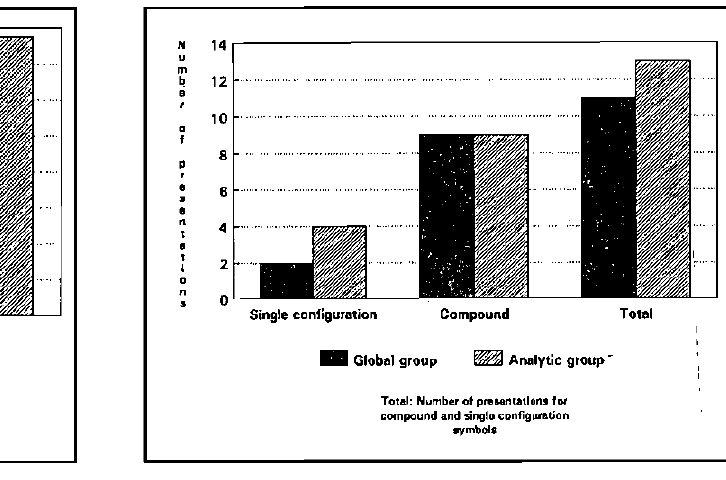
FIGURE 1: Results obtained during training: length of FIGURE 2: Results obtained during the generalization training procedure TABLE 5. Results obtained during the generalization